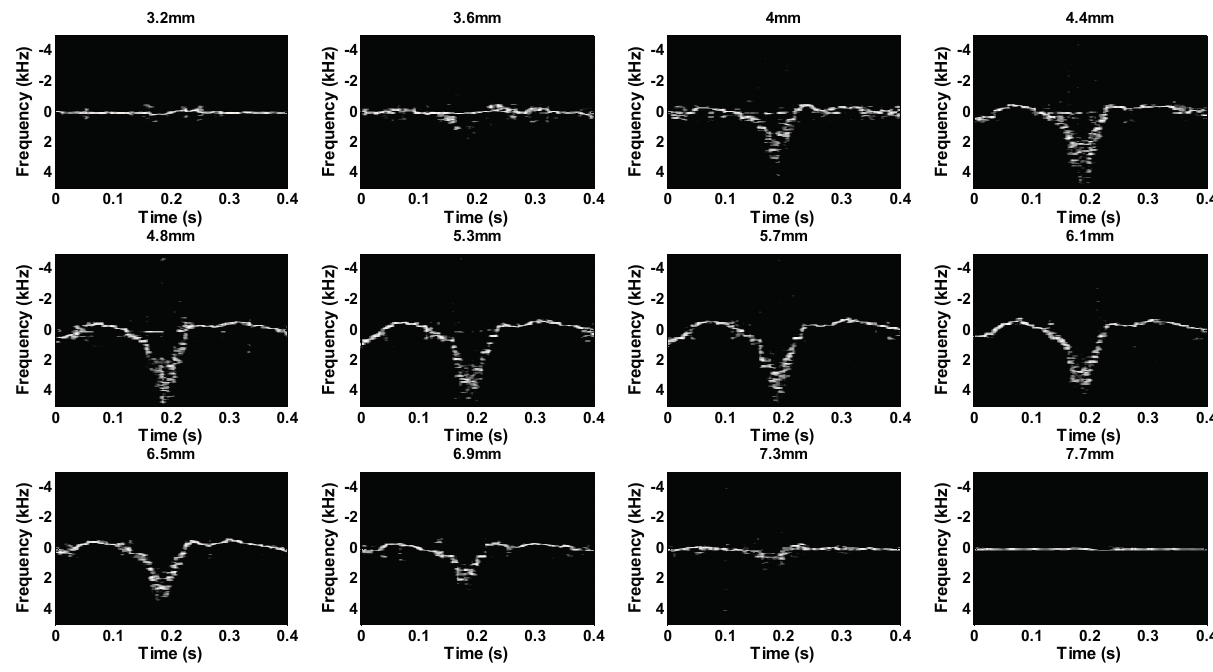
Figure 7. Sonogram of multigate PW Doppler with twelve interrogation gates.